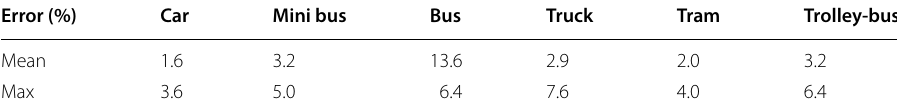
Table 4 Counting errors